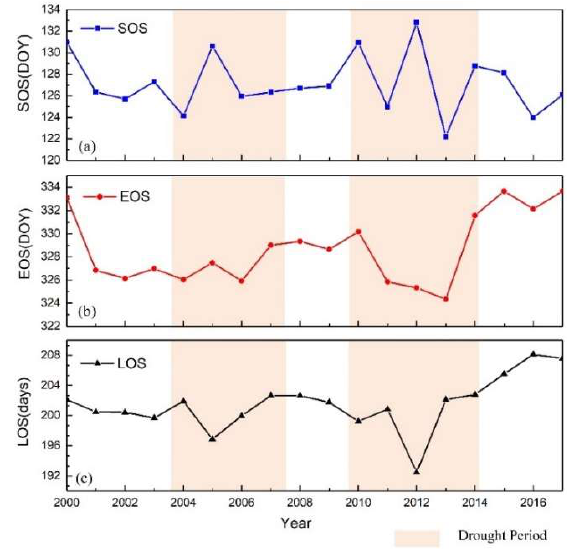
Figure 5. Variations of vegetation growth: ( a ) start of season (SOS), ( b ) end of season (EOS) and ( c ) length of season (LOS), (DOY means day of year).